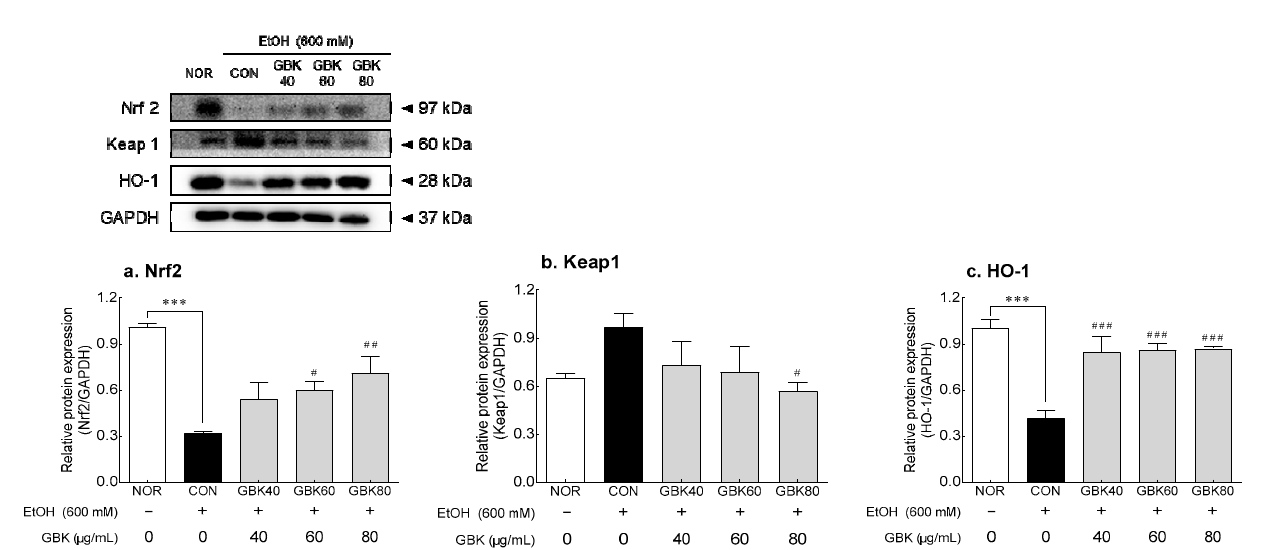
− − Figure 4. Effect of GBK on the protein expression of ( a ) Nrf2, ( b ) Keap1, and ( c ) HO-1 in ethanol- treated HepG2 cells . HepG2 cells were treated with GBK in the presence or absence of ethanol for 24 h. Values are mean ± SD. *** p < 0.001 vs. NOR group; # p < 0.05, ## p < 0.01, and ### p < 0.001 vs. CON group (ANOVA followed by Tukey’s test). EtOH, ethanol; Nrf2, nuclear factor-erythroid 2 related factor 2; Keap1, Kelch-like ECH-associated protein 1; HO-1, heme oxygenase-1. 3.4. Effects of GBK on Ethanol and Acetaldehyde Concentrations in the Blood of Ethanol-Treated Mice GBK was administered at low (KL, 15 mg/kg) and high (KH, 30 mg/kg) doses, and after 30 min, 25% ethanol was orally administered. After 0.5, 1, and 2 h, blood ethanol and